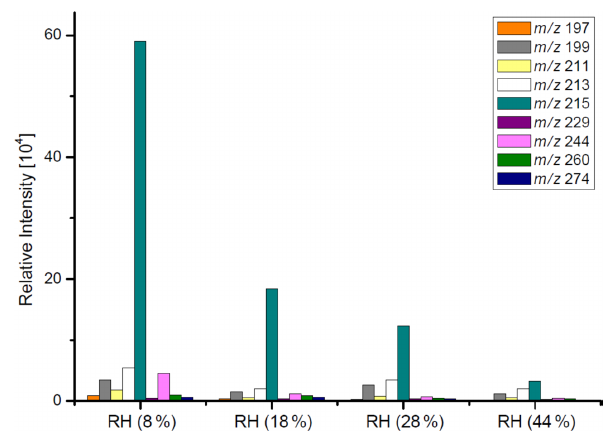
Figure 6. Influence of RH and seed acidity on the estimated concen- tration of 2-methylglyceric acid produced in chamber experiments with non-acidic seeds (red) and with acidic seeds (blue). See Fig. S3 for additional compounds.